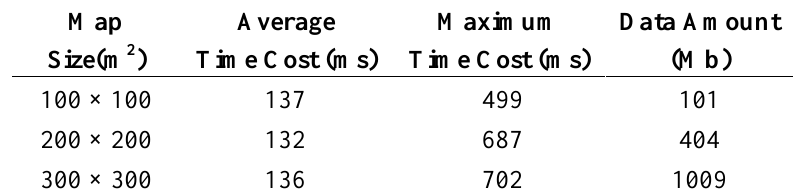
Table 3. The comparison of different likelihood map sizes with 1 cm map